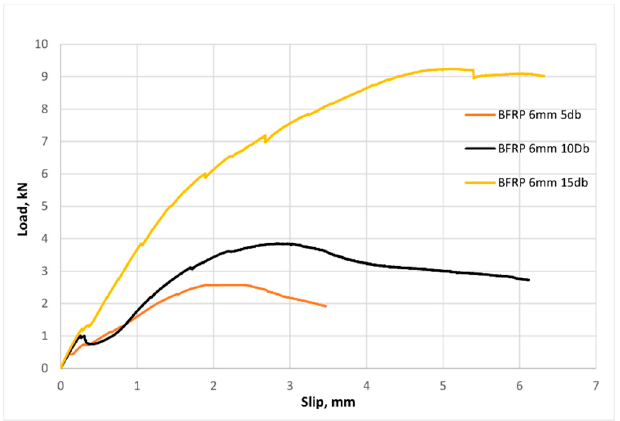
Figure 18 . Load–slip relationship of specimens with 6-mm BFRP bars of 5 d b ,10 d b , and 15 d b em- bedment lengths embedment